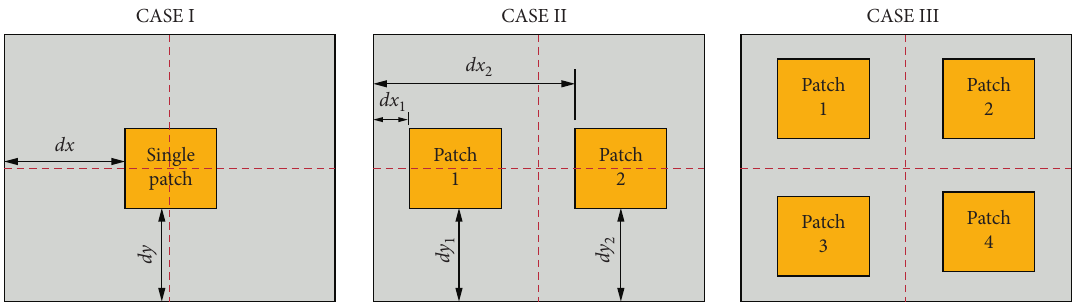
Figure 2: Patch numbering and locations on the substrate composite plate.